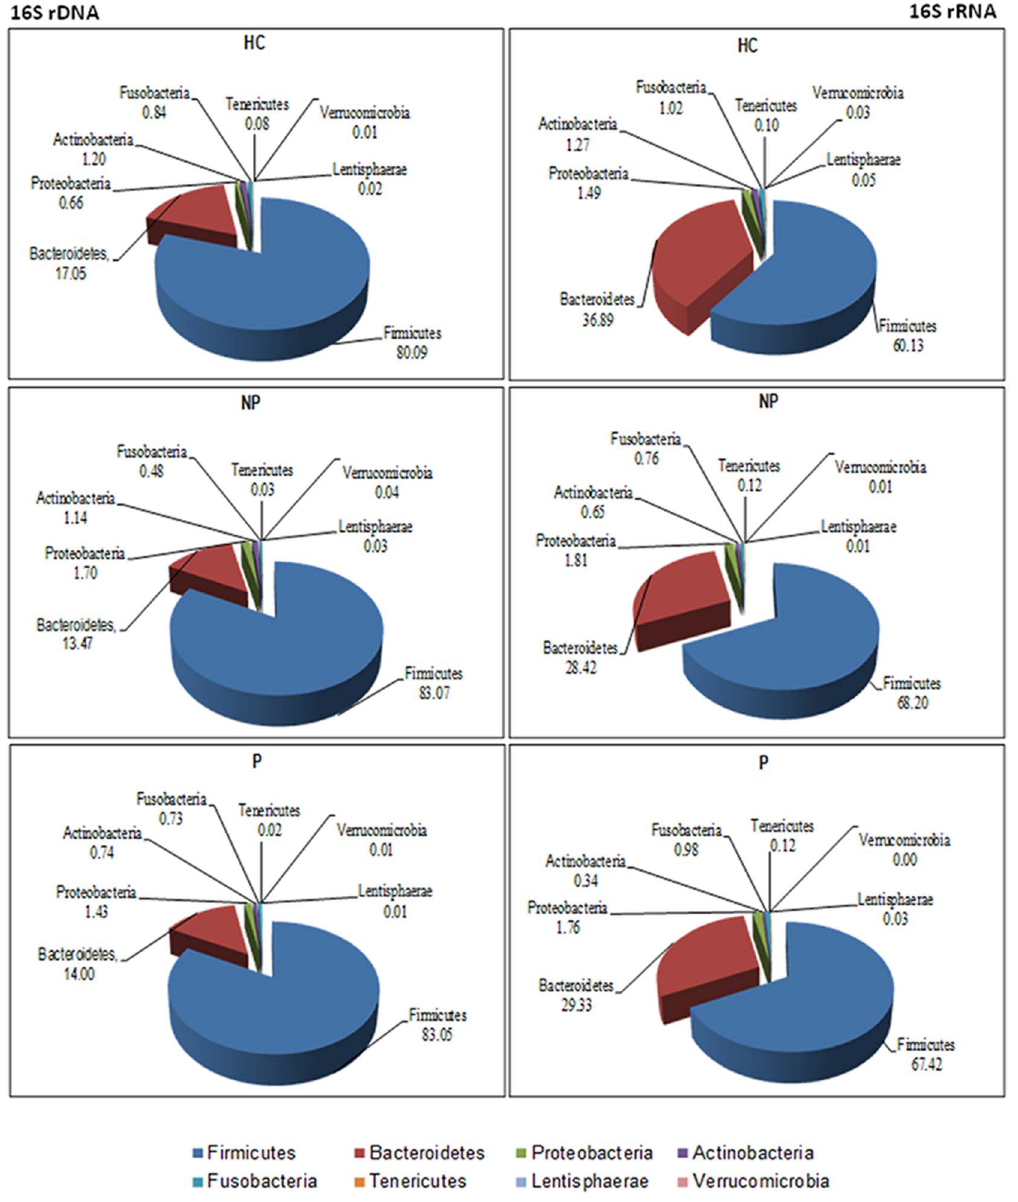
Figure 2. Total and active bacteria found in feces of subjects. Relative abundance (%) of total (16S rDNA) and metabolically active (16S rRNA) bacteria, which were found at the phylum level in the fecal samples of immunoglobulin A nephropathy (IgAN) non progressor (NP) and progressor (P) patients, and healthy controls (HC).